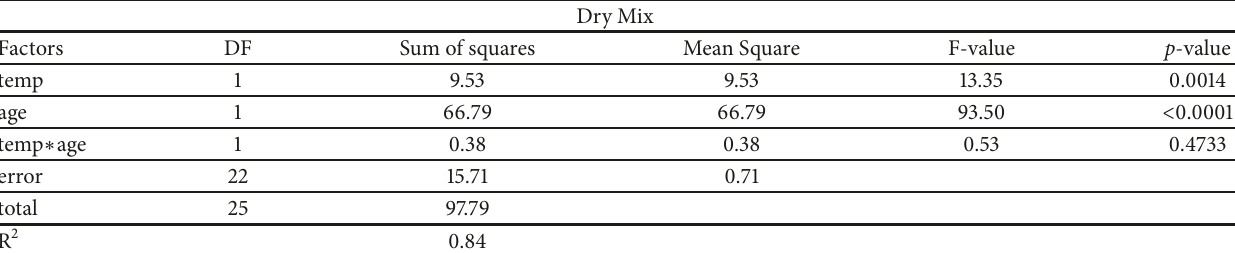
Table 6: ANOVA table for rut depth for dry mix without samples 1 and